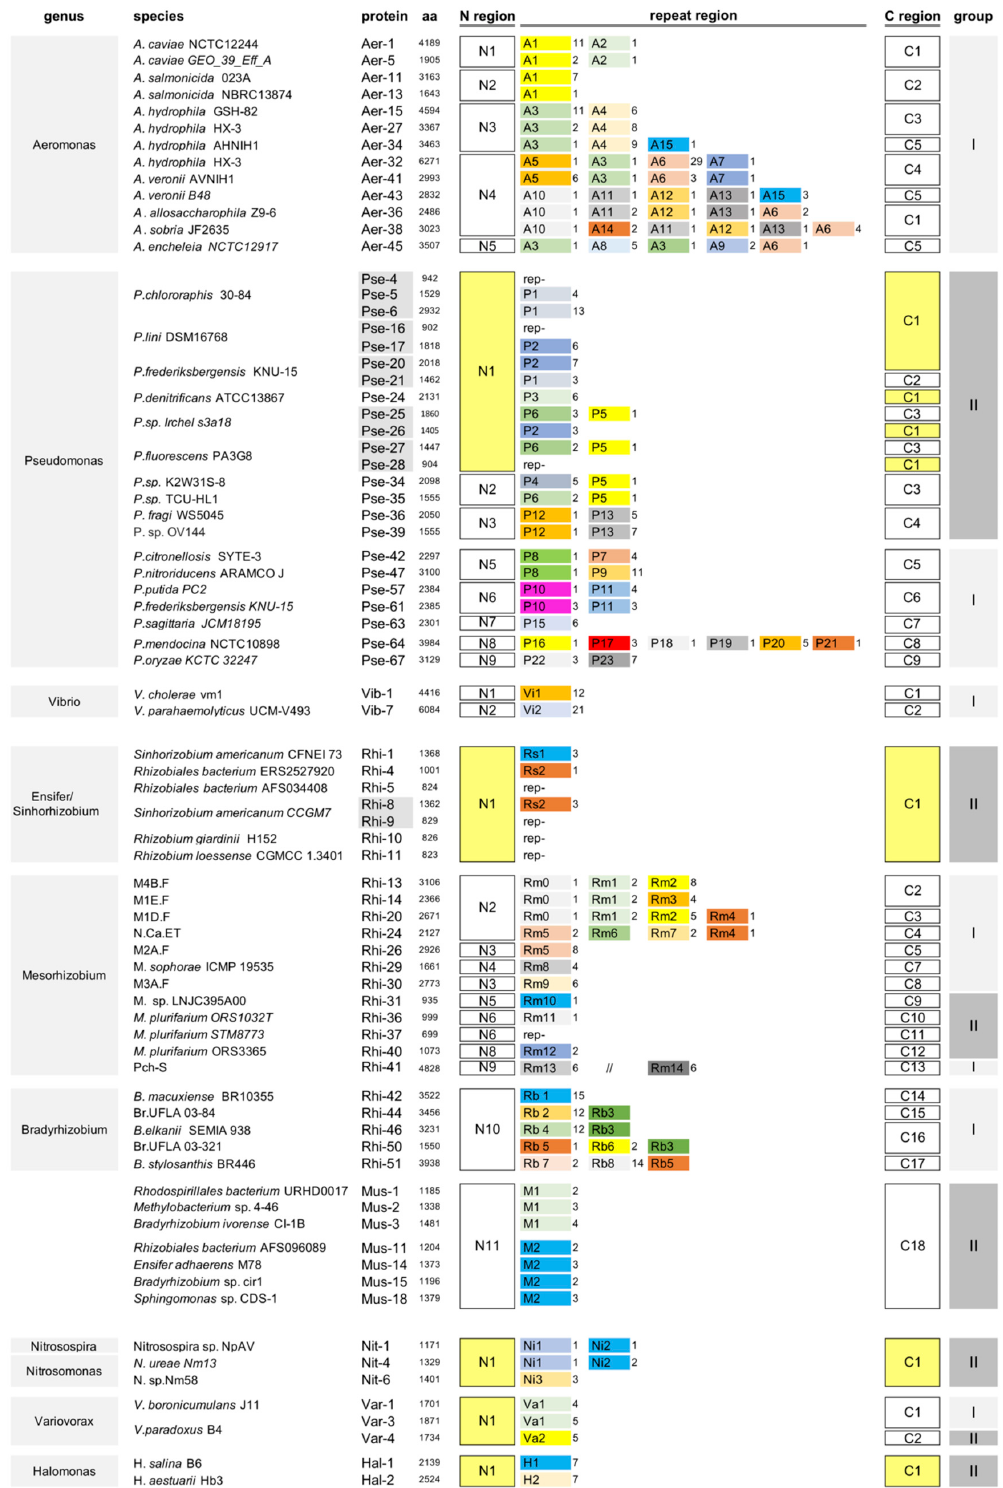
Figure 3. DDxP proteins. All proteins are labeled by a three ‐ letter code denoting the genus. N and C regions are numbered, and repeats are colored in a genus ‐ specific manner. Proteins lacking repeats are denoted as rep ‐ . Proteins carrying or lacking RTX repeats are denoted as gr I or II, respectively (see light and dark grey bars to the right). Proteins encoded by adjacent genes are highlighted. Protein IDs, sources, and places of isolation of the producer strains are reported in Figure S2.